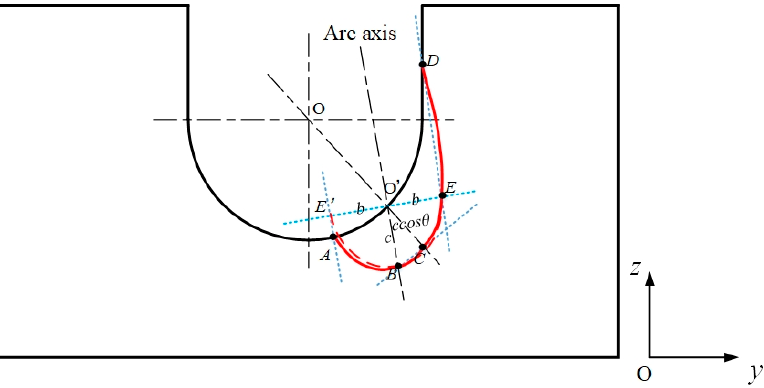
Figure 5. Heat distribution in narrow-gap welding.